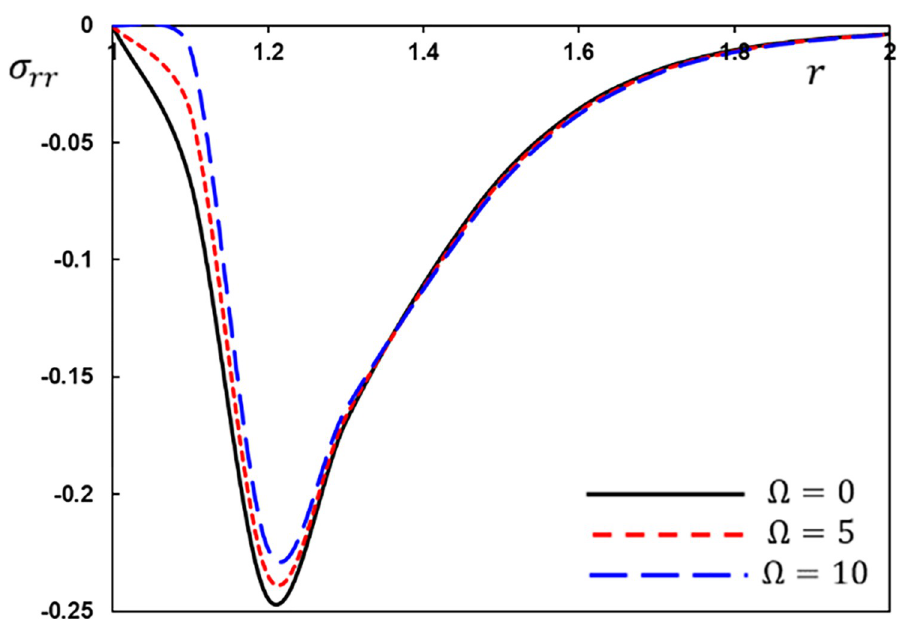
Fig 7. The radial stress variation σ